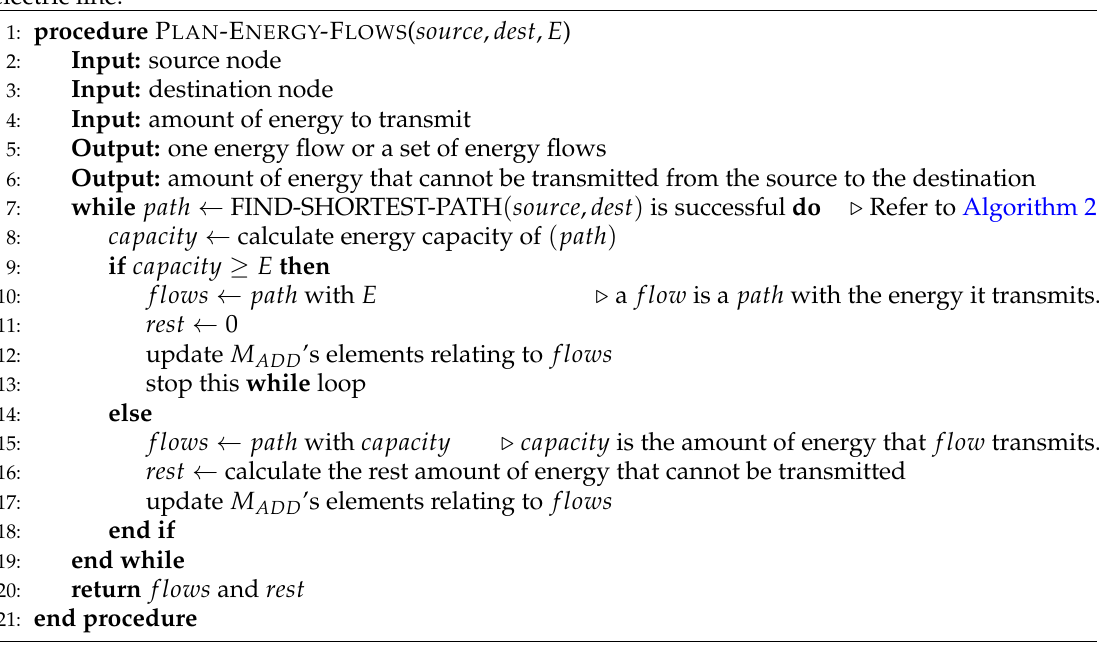
Algorithm 3 Plan energy flows from a provider to a consumer. The algorithm plans one or multiple paths to transmit energy from the provider to the consumer considering the energy capacity of each electric